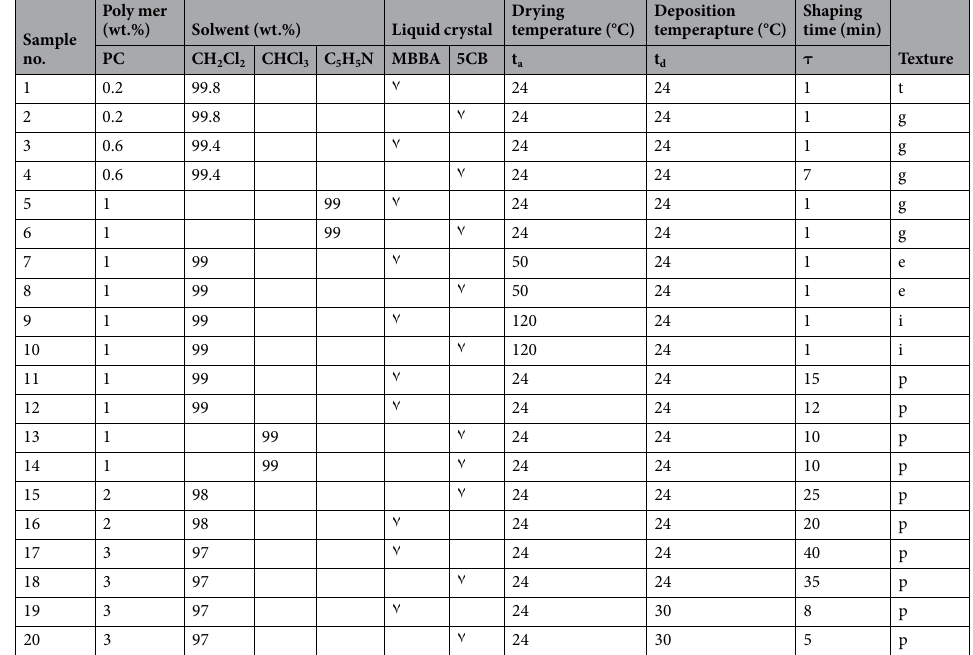
Table 1. The preparation conditions and types of nematic textures on the polymer surface. t – thread-likes texture; g – grain-shaped texture; e – enhangled thread-likes texture; i – island-shaped texture; p – polygon nematic